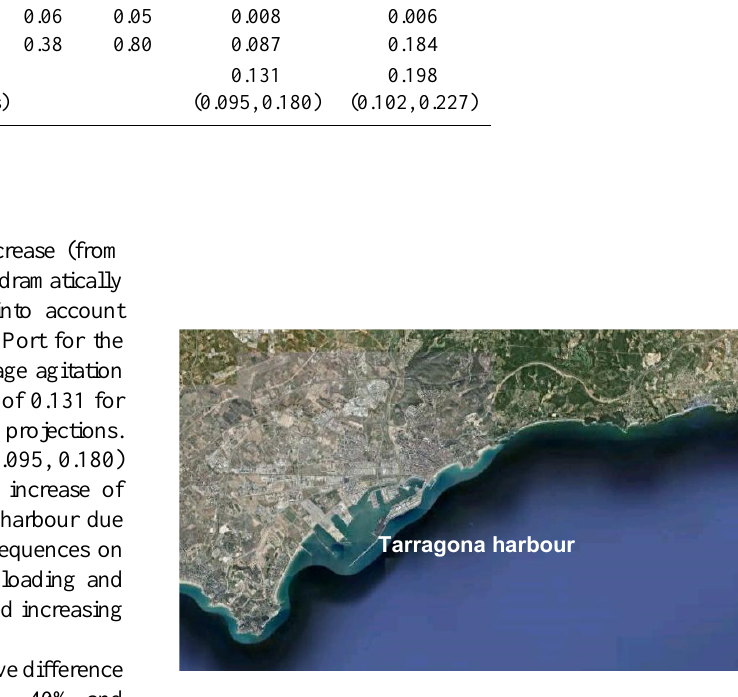
Fig. 13. Plan of the Tarragona Port and surrounding coast, showing that headlands prevent waves from NE and SW from reaching the port